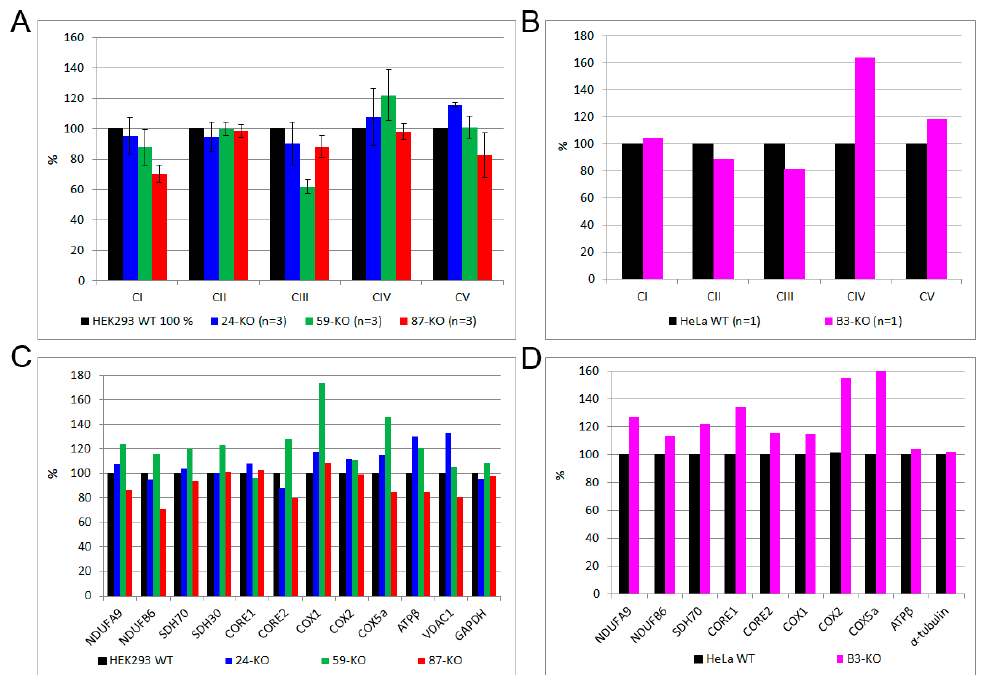
Figure A2. ( A ) Western blots of selected Golgi proteins in HEK293 ACBD3-KO cells. ( B ) Glycosyl- ation of LAMP2 glycoprotein in HEK293 ACBD3-KO cells.